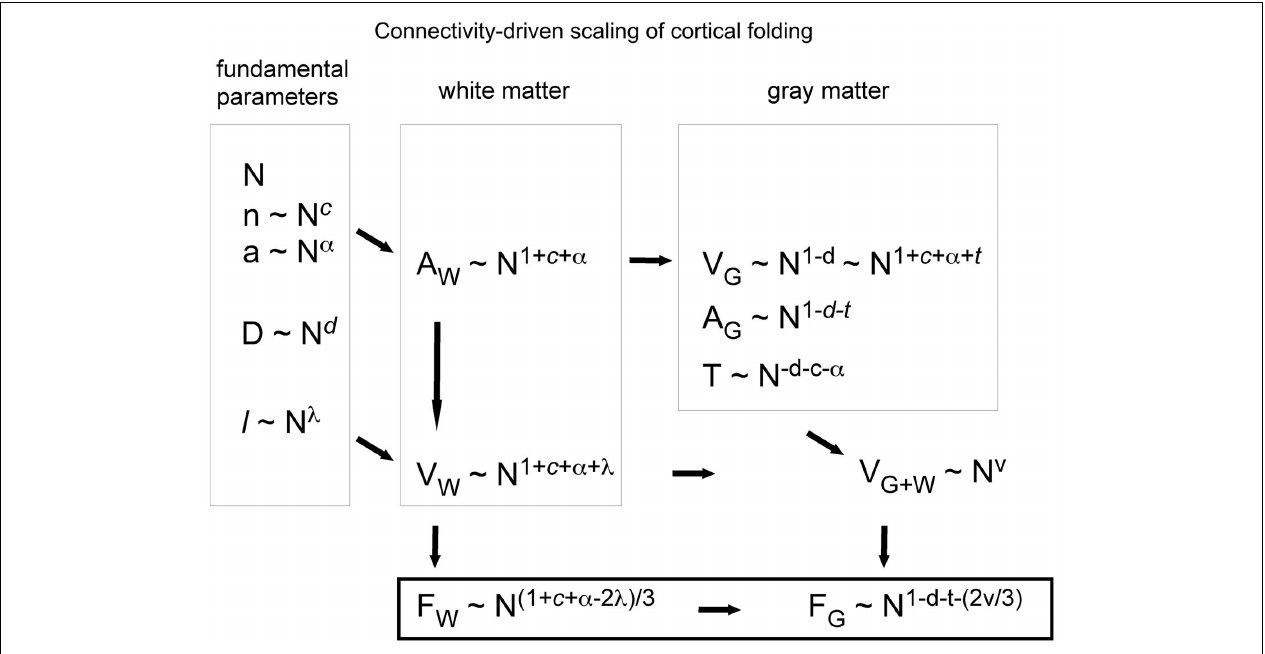
volume in the gray matter), and the average axonal length in the white matter ( l ). Next, white matter surface ( A W ) and volume ( V W ) are organized as shown, depending on N and the scaling exponents, and thus determine the folding of the white matter surface ( F W ). On top of A W , the gray matter becomes organized depending on the average size of its neurons, which, combined to a and n , determine cortical thickness,T.The degree of folding of the gray matter, F G , is thus a consequence of the folding of the white matter, which is in turn dependent on how the parameters determining cortical connectivity ( c , a , and l ) scale with N